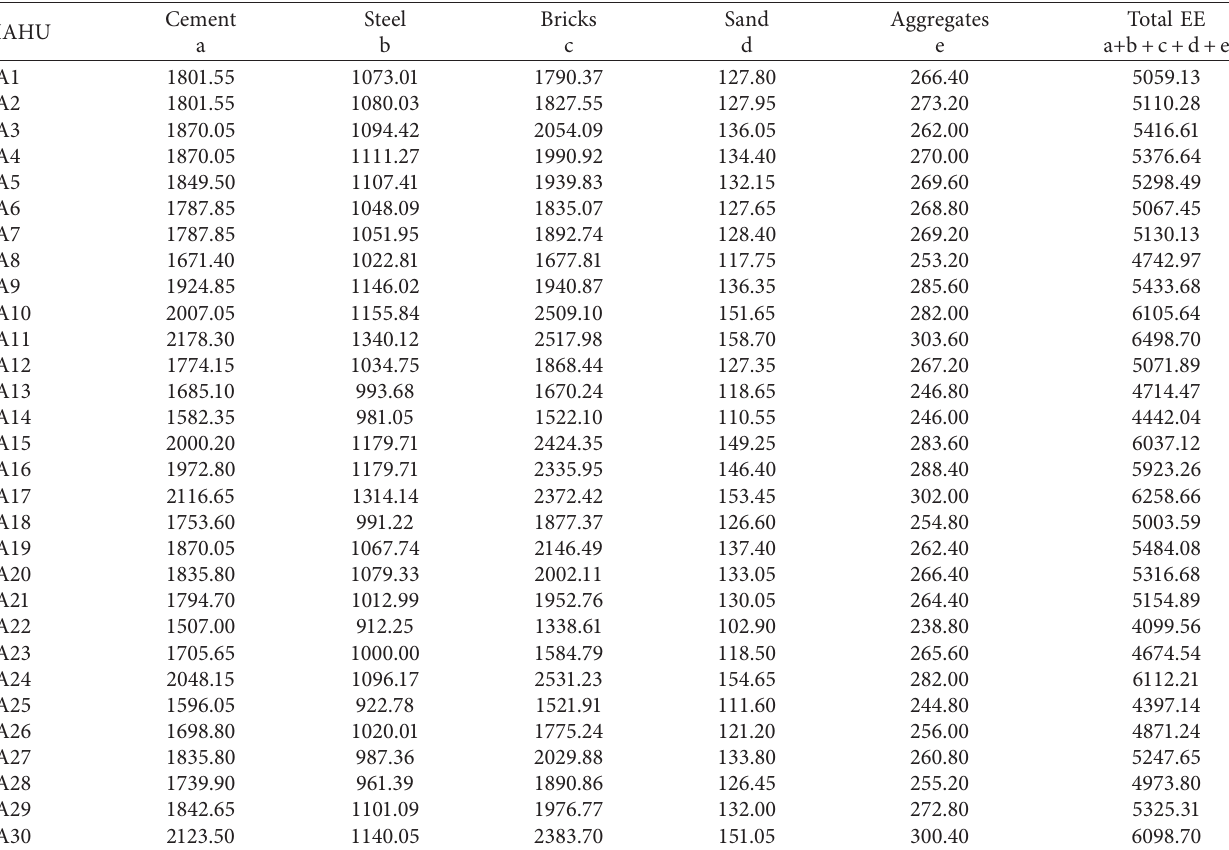
Table 7: EE of major construction materials for selected 30 IAHUs in MJ/m 2 of the carpet area. IAHU